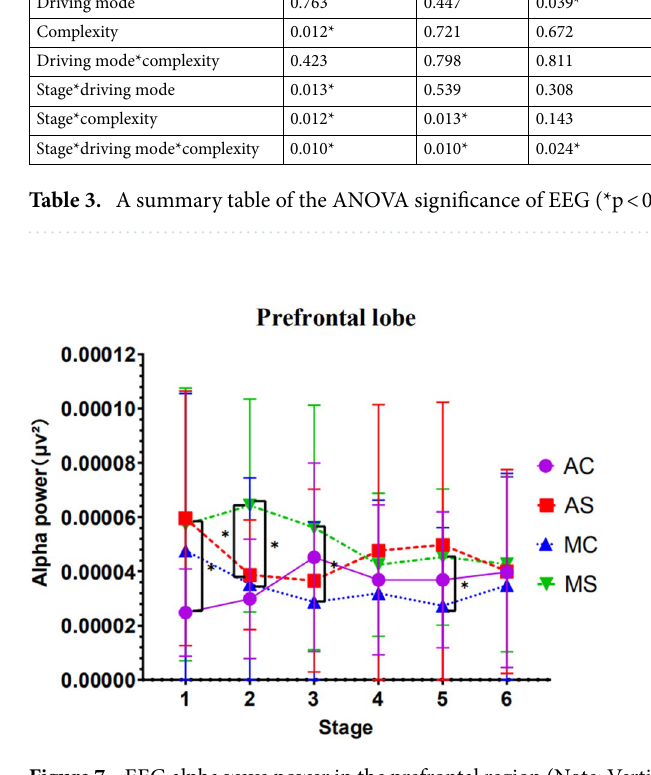
Figure 7. EEG alpha wave power in the prefrontal region (Note: Vertical bars represent standard errors, * p <